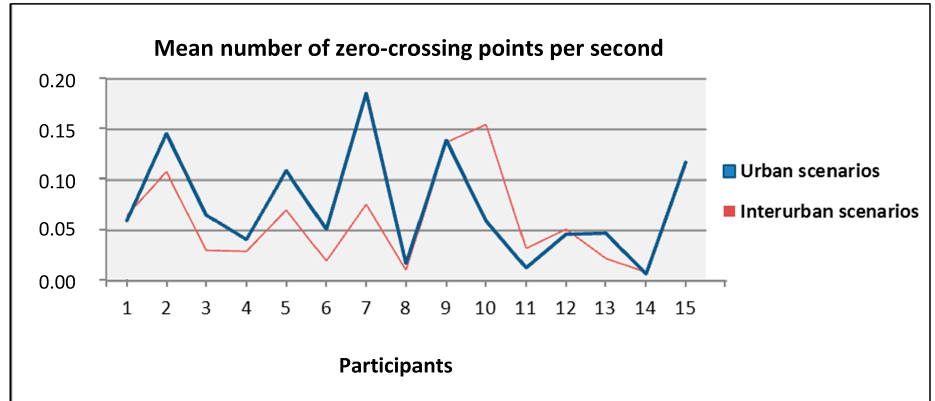
Figure 16. Mean number of zero-crossing points per second for urban and interurban scenarios per each participant.